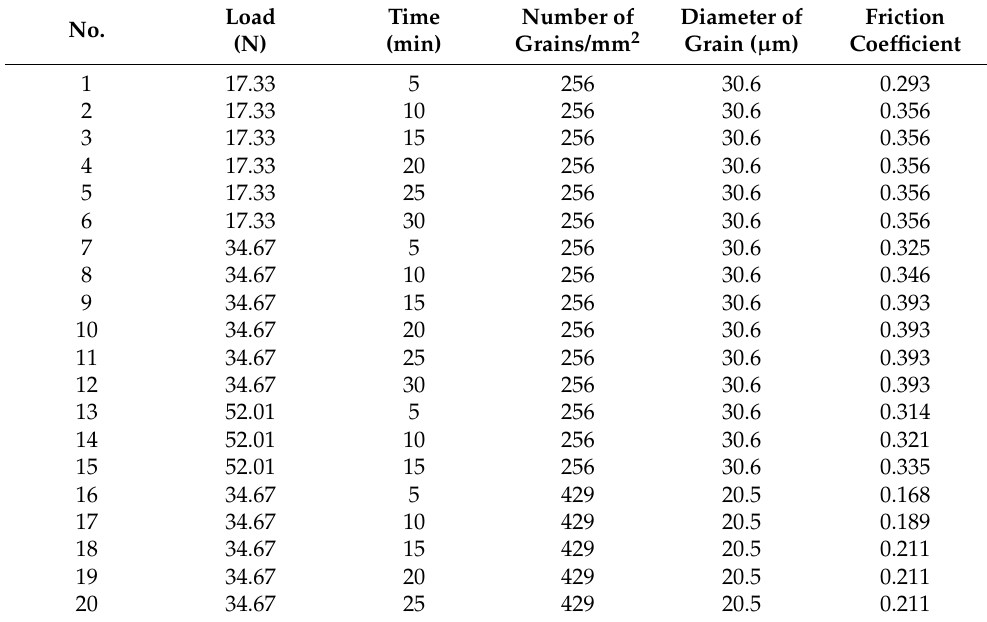
Table 4. Friction coefficients for different ductile cast-iron